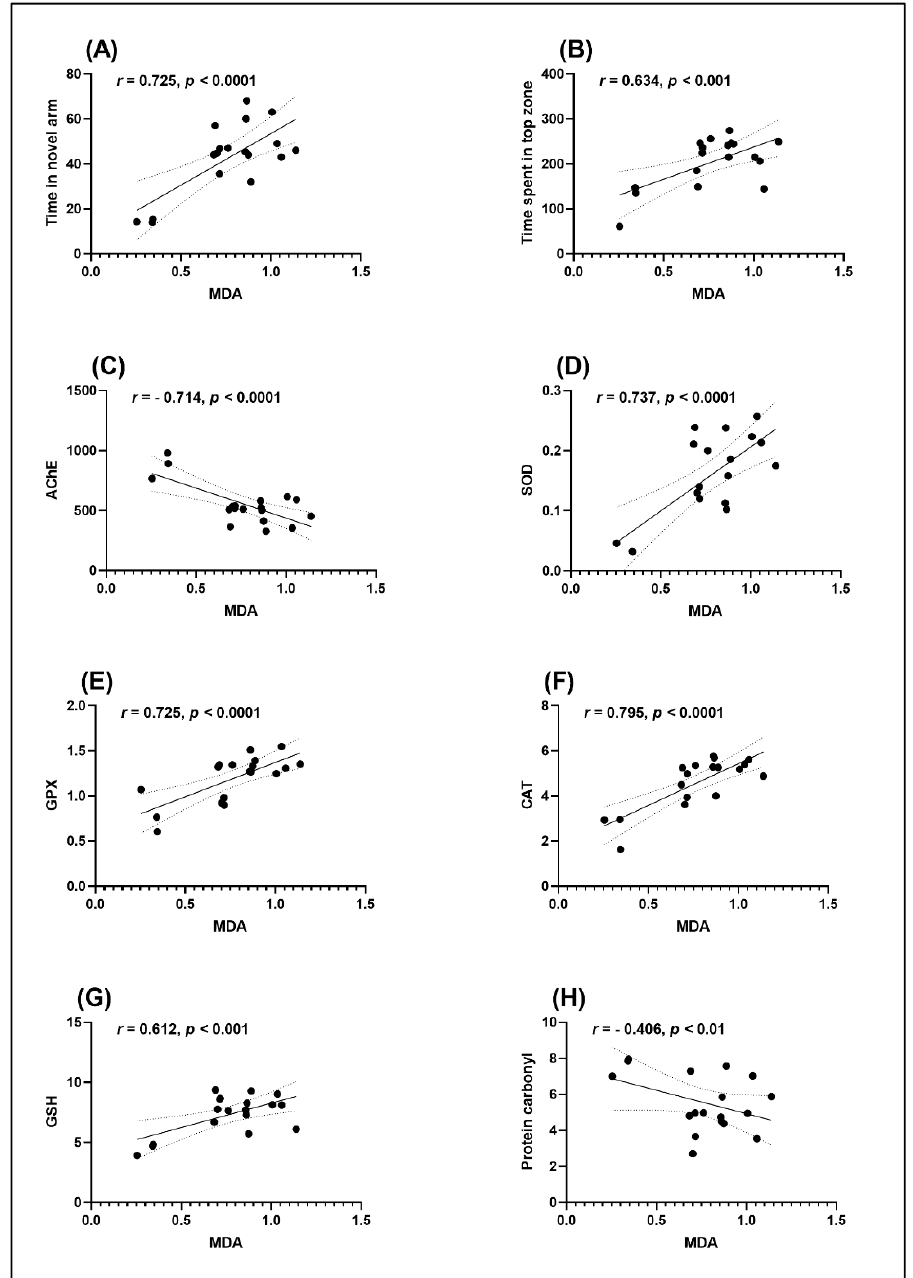
Figure 7. Correlation analyses between behavioral and biochemical parameters (Pearson’s correlation). Data expressed are time in the novel arm (s), time spent in the top zone (s), AChE (nmol/min/mg protein), SOD (U/mg protein), GPX (U/mg protein), CAT (U/mg protein), GSH ( μ g GSH/ μ g protein), protein carbonyl (nmol/mg protein) and MDA (nmol/mg protein). ( A ) Time in novel arm vs. MDA ( n = 10, r = 0.725, p < 0.0001); ( B ) Time spent in the tope zone vs. MDA ( n = 10, r = 0.634, p < 0.001); ( C ) AChE vs. MDA ( n = 10, r = − 0.714, p < 0.0001); ( D ) SOD vs. MDA ( n = 10, r = 0.737, p < 0.0001); ( E ) GPX vs. MDA ( n = 10, r = 0.725, p < 0.0001), ( F ) CAT vs. MDA ( n = 10, r = 0.795, p < 0.0001), ( G ) GSH vs. MDA ( n = 10, r = 0.612, p < 0.001) and ( H ) Protein carbonyl vs. MDA ( n = 10, r = − 0.406, p <